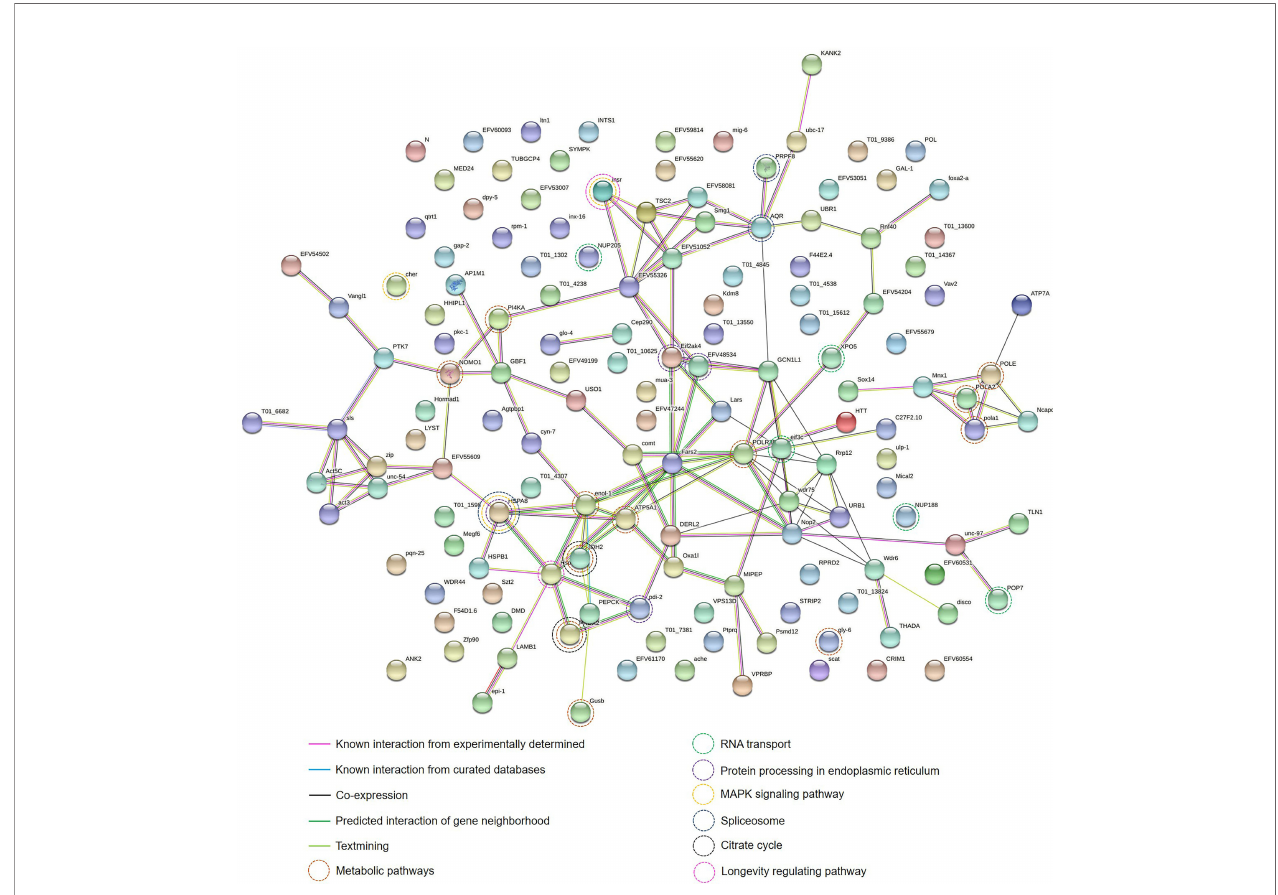
FIGURE 4 | Protein-protein interaction network of identi fi ed proteins of the muscle larval extract (LE) of Trichinella spiralis using the STRING database. The types of interactions are represented by different colored lines (lower left panel). The functions of each protein-encoding gene are represented by different colored circle lines (lower right